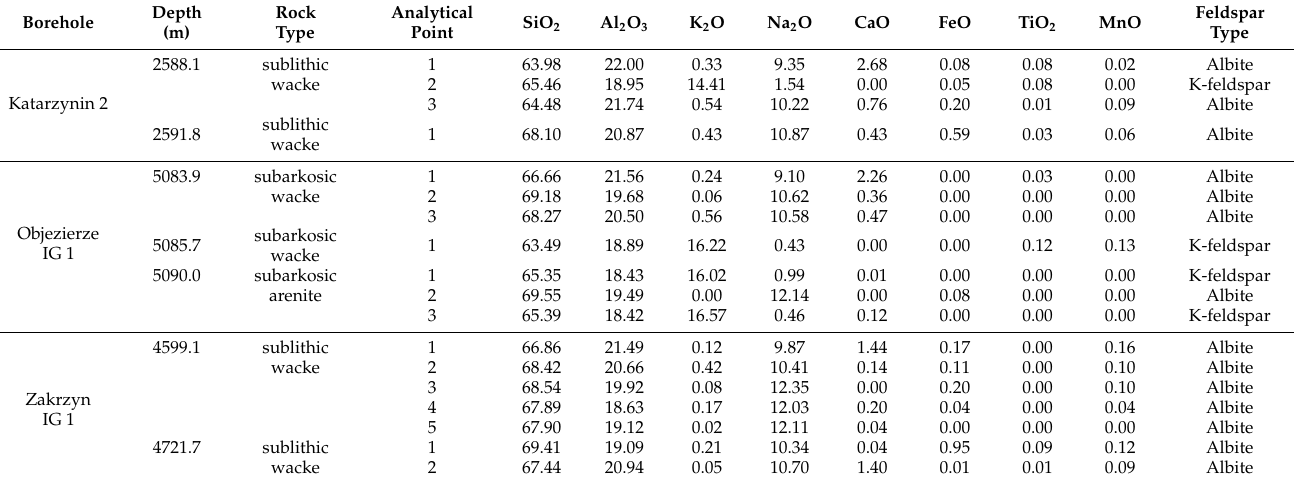
Table 1. Results of microprobe chemical analysis of